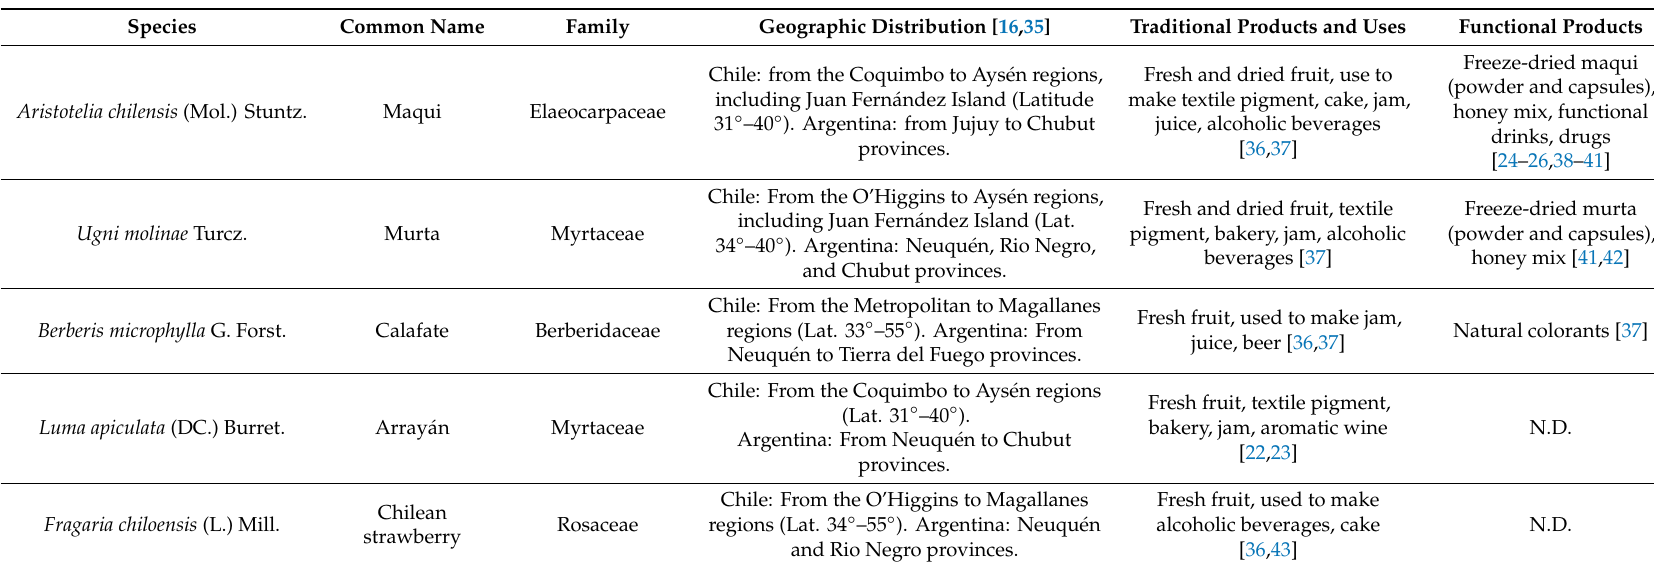
Table 1. Main features of Patagonian fruits analyzed in the present review. Scientific and common names, botanic family, geographic distribution, traditional products and uses, and functional products generated in the last